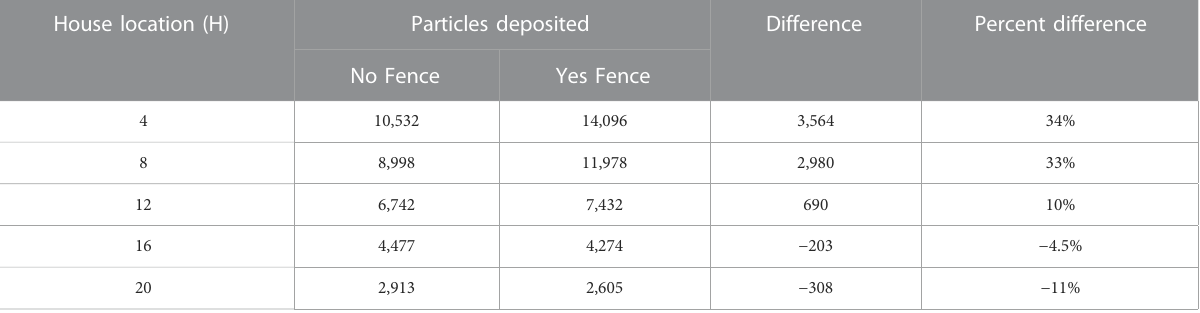
TABLE 2 Firebrand deposition totals and differences on the house with and without a vegetation fence at a given house location. Deposition on the house includes deposition on any surface of the house (i.e., all fi ve exposed house surfaces). Positive numbers: increased total deposition; negative numbers: decreased total